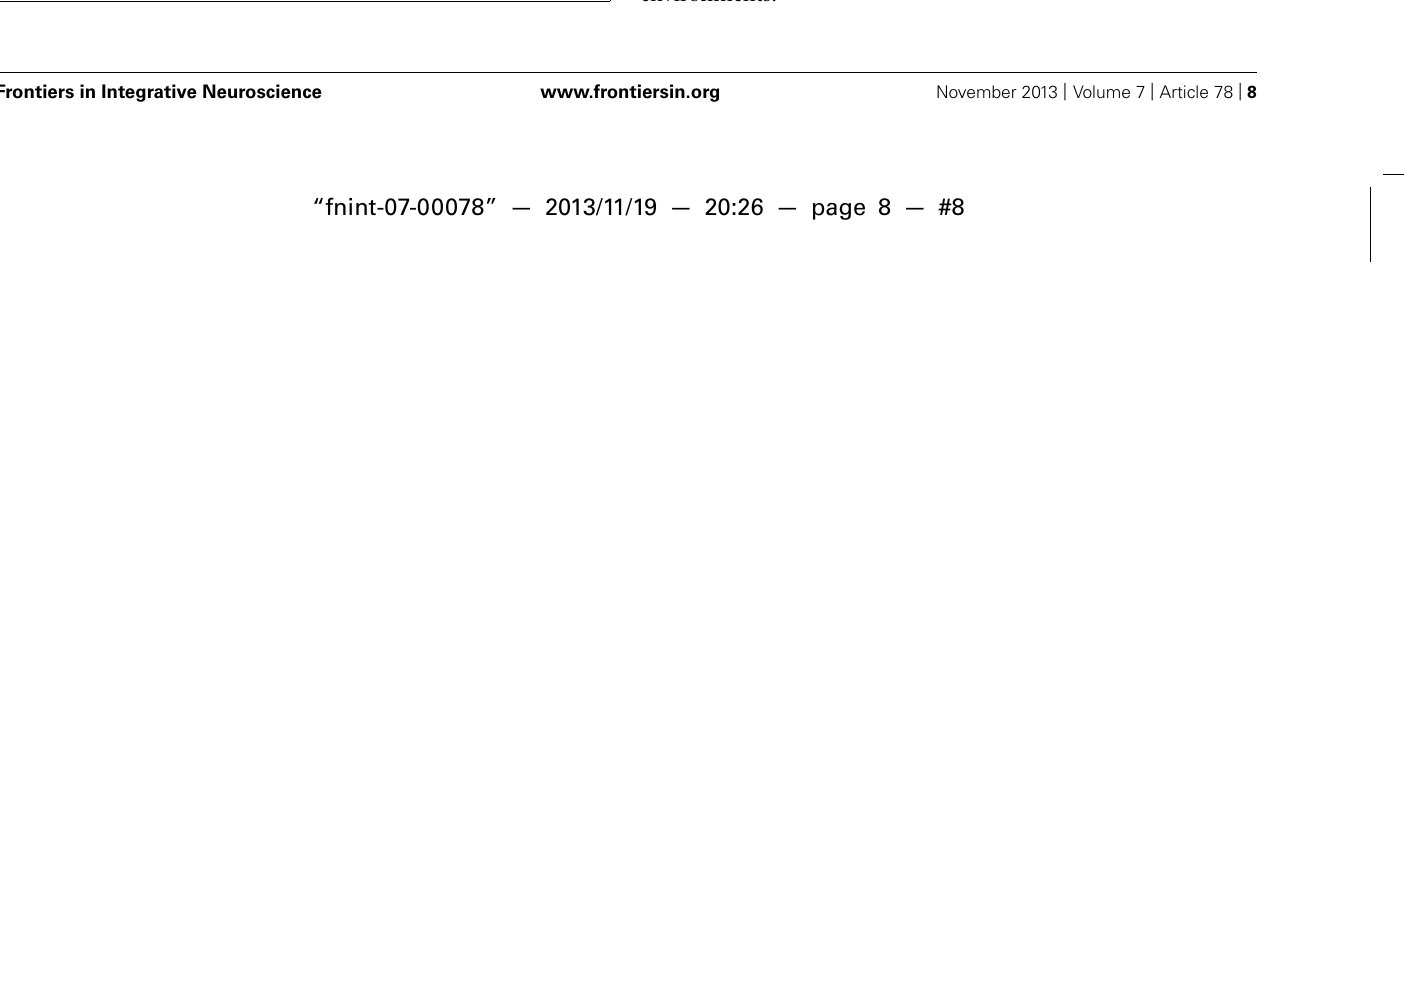
FIGURE 4 | Chicken game diagram. Two toy cars, one driven by the human and one by the neural agent, were placed at opposite ends of a track.The cars started moving toward each other at the same speed and at the same time, at which point players must decide whether to conservatively swerve out of the way, but take a smaller payoff, or take the risk of a collision and continue straight ahead in hopes of a larger payoff. © 2012 IEEE. Reprinted, with permission, from Asher etal.